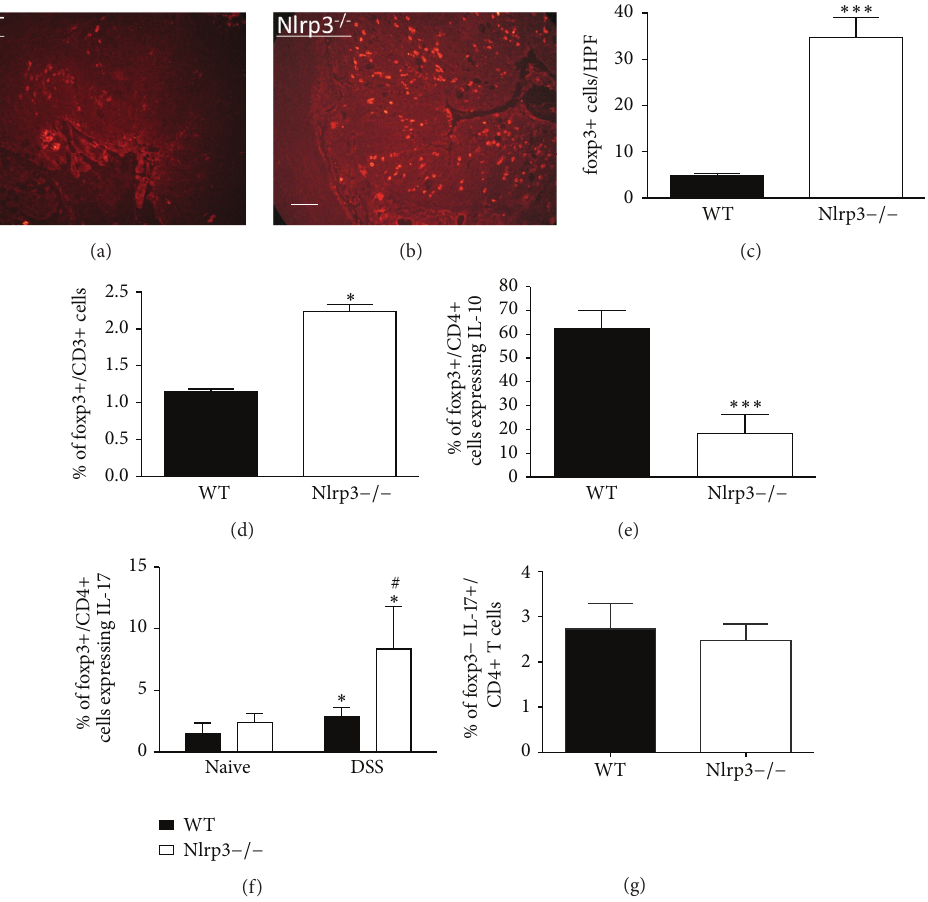
Figure 2: DSS-treated Nlrp3 − / − mice exhibit increased numbers of colonic foxp3+ cells that exhibit reduced IL-10 but increased IL-17 expression. Representative images of (a) WT and (b) Nlrp3 − / − colonic sections stained for foxp3; scale bar = 50 microns. (c) Quantification of foxp3+ cells in WT versus Nlrp3 − / − mice on following 7 days of DSS exposure. Data are expressed as the number of foxp3+ cells per high-powered field (HPF). ∗∗∗ denotes 𝑝 < 0.005 compared to WT mice; 𝑛 = 6 /group; 4 HPF/mouse. (d) Flow cytometric analysis of foxp3+/CD3+ cells isolated from the LP of WT versus Nlrp3 − / − mice on following 7 days of DSS exposure. ∗ denotes 𝑝 < 0.05 compared to WT mice; 𝑛 = 6 /group. (e) Flow cytometric analysis of IL-10 expression in foxp3+/CD4+ T regulatory cells isolated from the LP of WT and Nlrp3 − / − mice on day 7 of DSS. ∗∗∗ denotes 𝑝 < 0.005 compared to WT nice; 𝑛 = 5 /group. (f) IL-17 expression in foxp3+/CD4+ cells isolated from the LP of naive and DSS-treated WT and Nlrp3 − / − mice. ∗ denotes 𝑝 < 0.05 compared to naive mice; # denotes 𝑝 < 0.05 compared to WT mice; 𝑛 = 6 /group. (g) IL-17 expression in foxp3 − /CD4+ cells isolated from the LP DSS-treated WT and Nlrp3 − / − mice; 𝑛 = 6